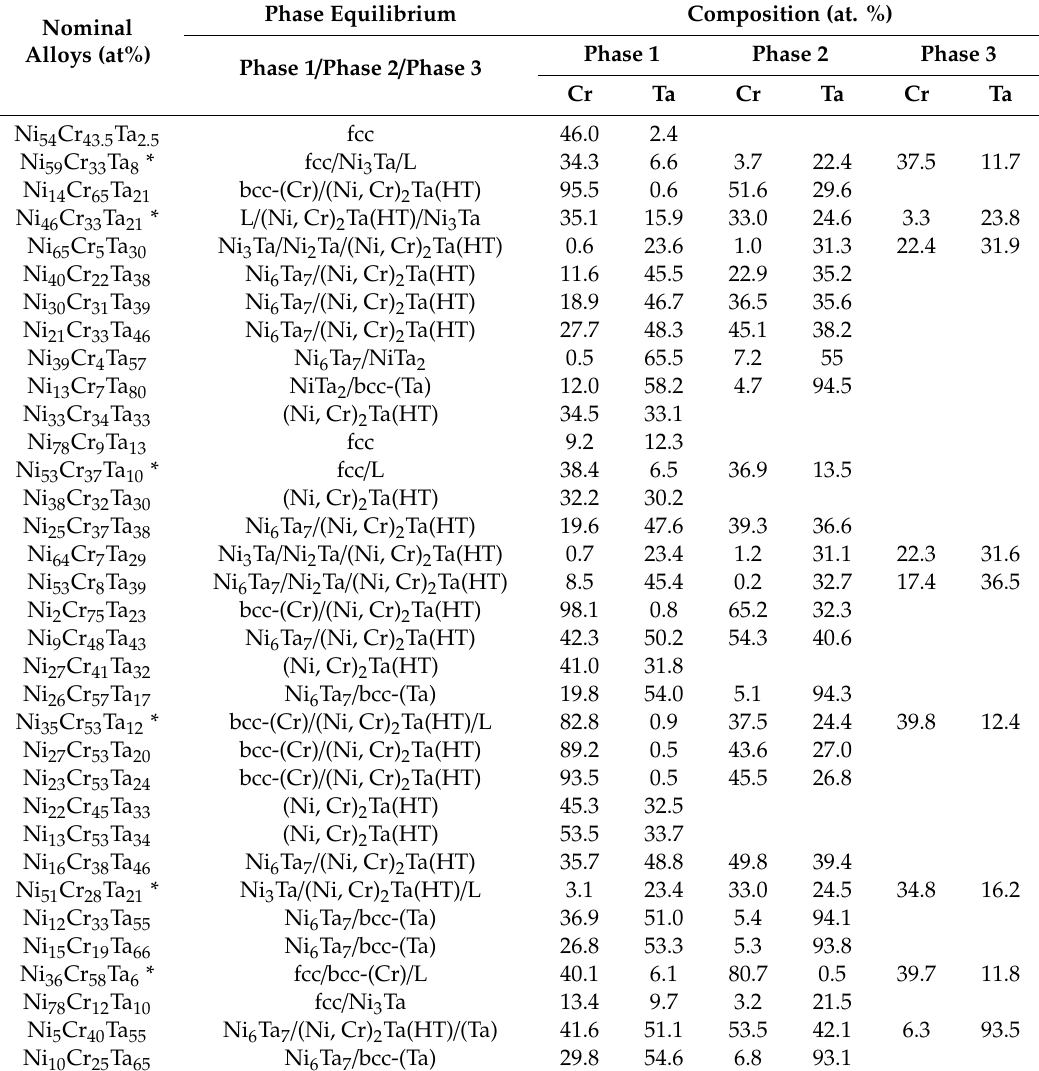
Table 3. Equilibrium compositions of each phase in the Ni-Cr-Ta ternary alloys annealed at 1300 ◦ C for 15 days or 3